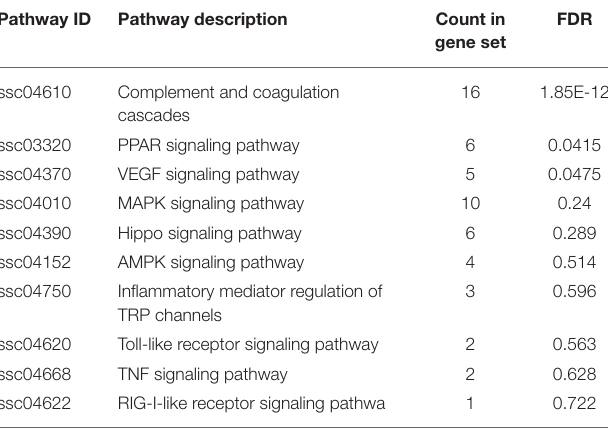
TABLE 1 | Kyoto encyclopedia of genes and genomes information on the vesicular fluid. Pathway ID